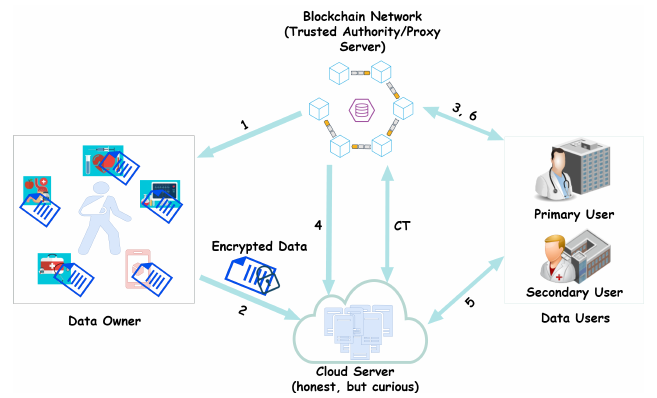
Figure 1. System